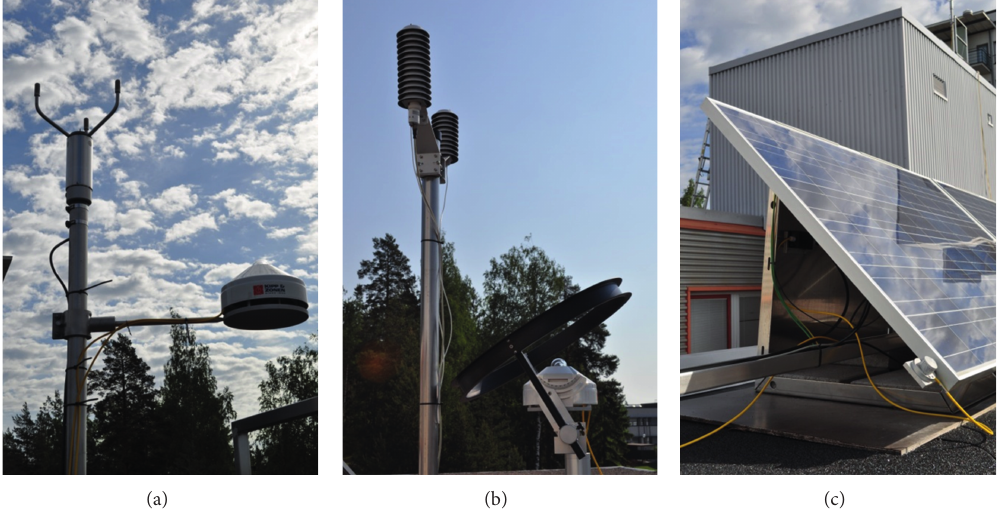
Figure 3: (a) WS425 wind sensor and CMP22 pyranometer, (b) HMP155 sensors with temperature and humidity probes equipped with radiation shields and CMP21 pyranometer combined with the CMC121 shadow ring, and (c) SPLite2 photodiode sensor attached to a PV